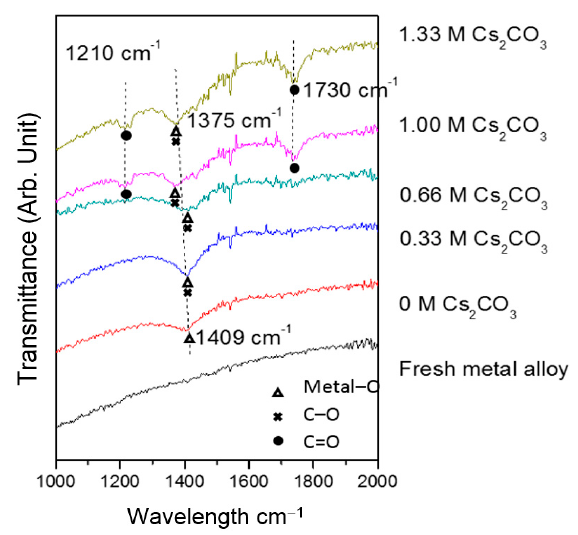
Figure 4. Fourier transform infrared (FTIR) spectra of the fresh and cycled AR3 in the 6.77 M KOH, 6.44 M KOH + 0.33 M Cs 2 CO 3 , 6.11 M KOH + 0.66 M Cs 2 CO 3 , 5.77 M KOH + 1.00 M Cs 2 CO 3 , and 5.44 M KOH + 1.33 M Cs 2 CO 3 electrolytes.